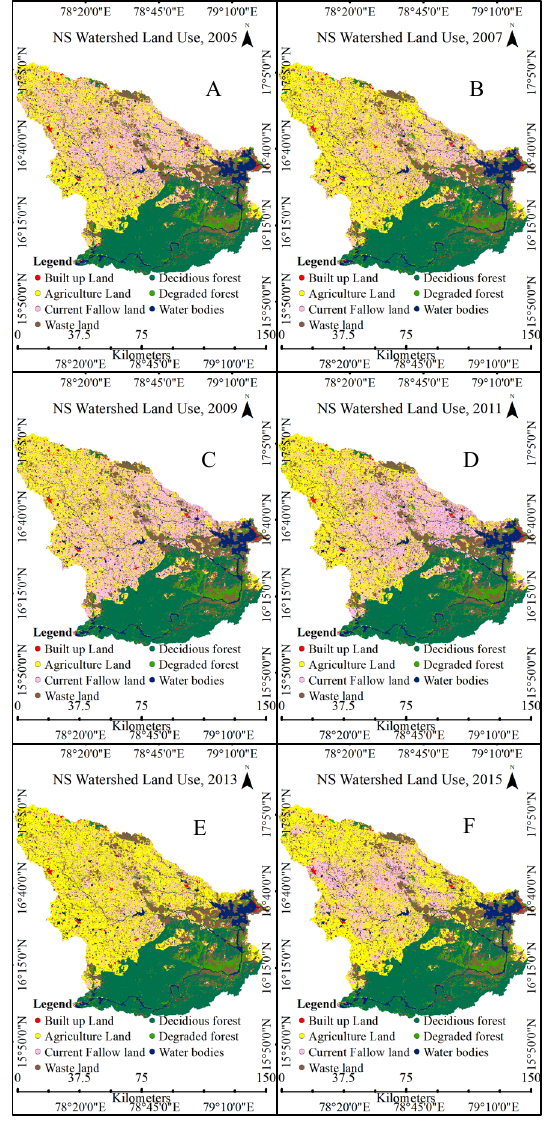
Figure 7: Shows the changes occurring in the Land Use pattern in NS contributing watershed for every two years from 2005 (A) to 2015 (F)